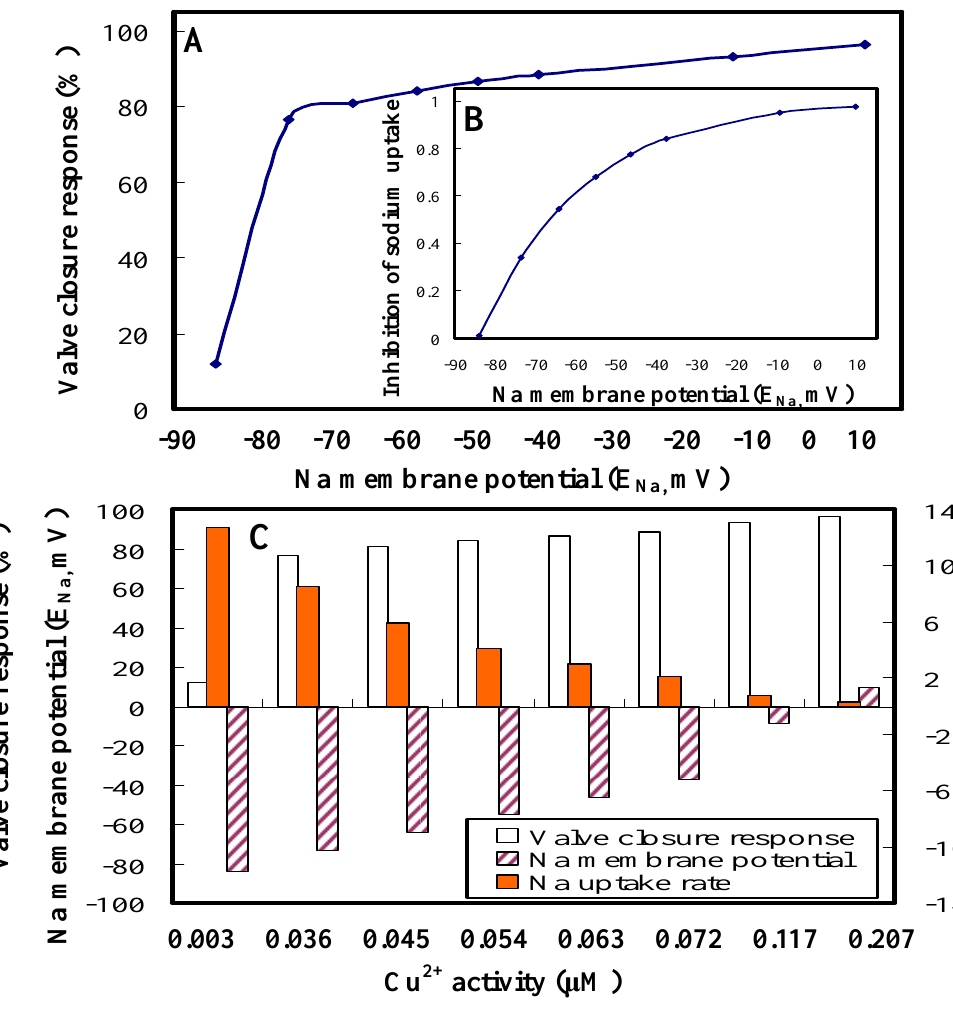
Figure 4. Predicted biological and electrophysiological responses that includes clam valve closure behavior, Na uptake, and gill potentials. (A) Relationships between closure response and electrophysiological properties (Na membrane potential). (B) Relationships between inhibition of Na uptake and Na membrane potential. (C) Cu 2+ activity-dependent interactions, showing that changes of valve closure response, Na uptake rate, and Na membrane